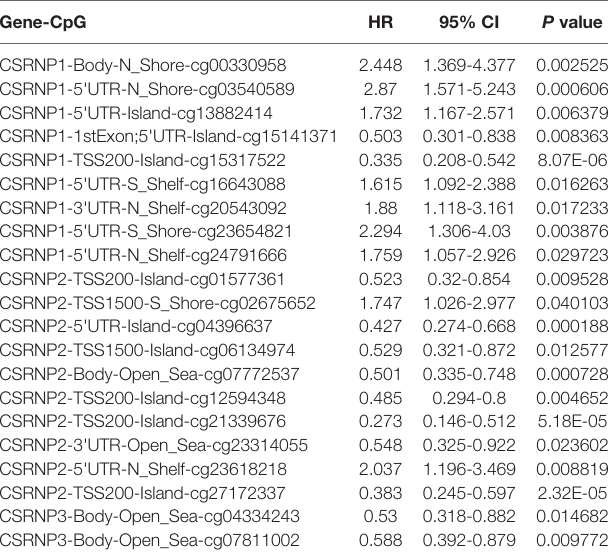
TABLE 3 | The signi fi cantly prognostic values of CpG in the CSRNP family. Gene-CpG HR 95%